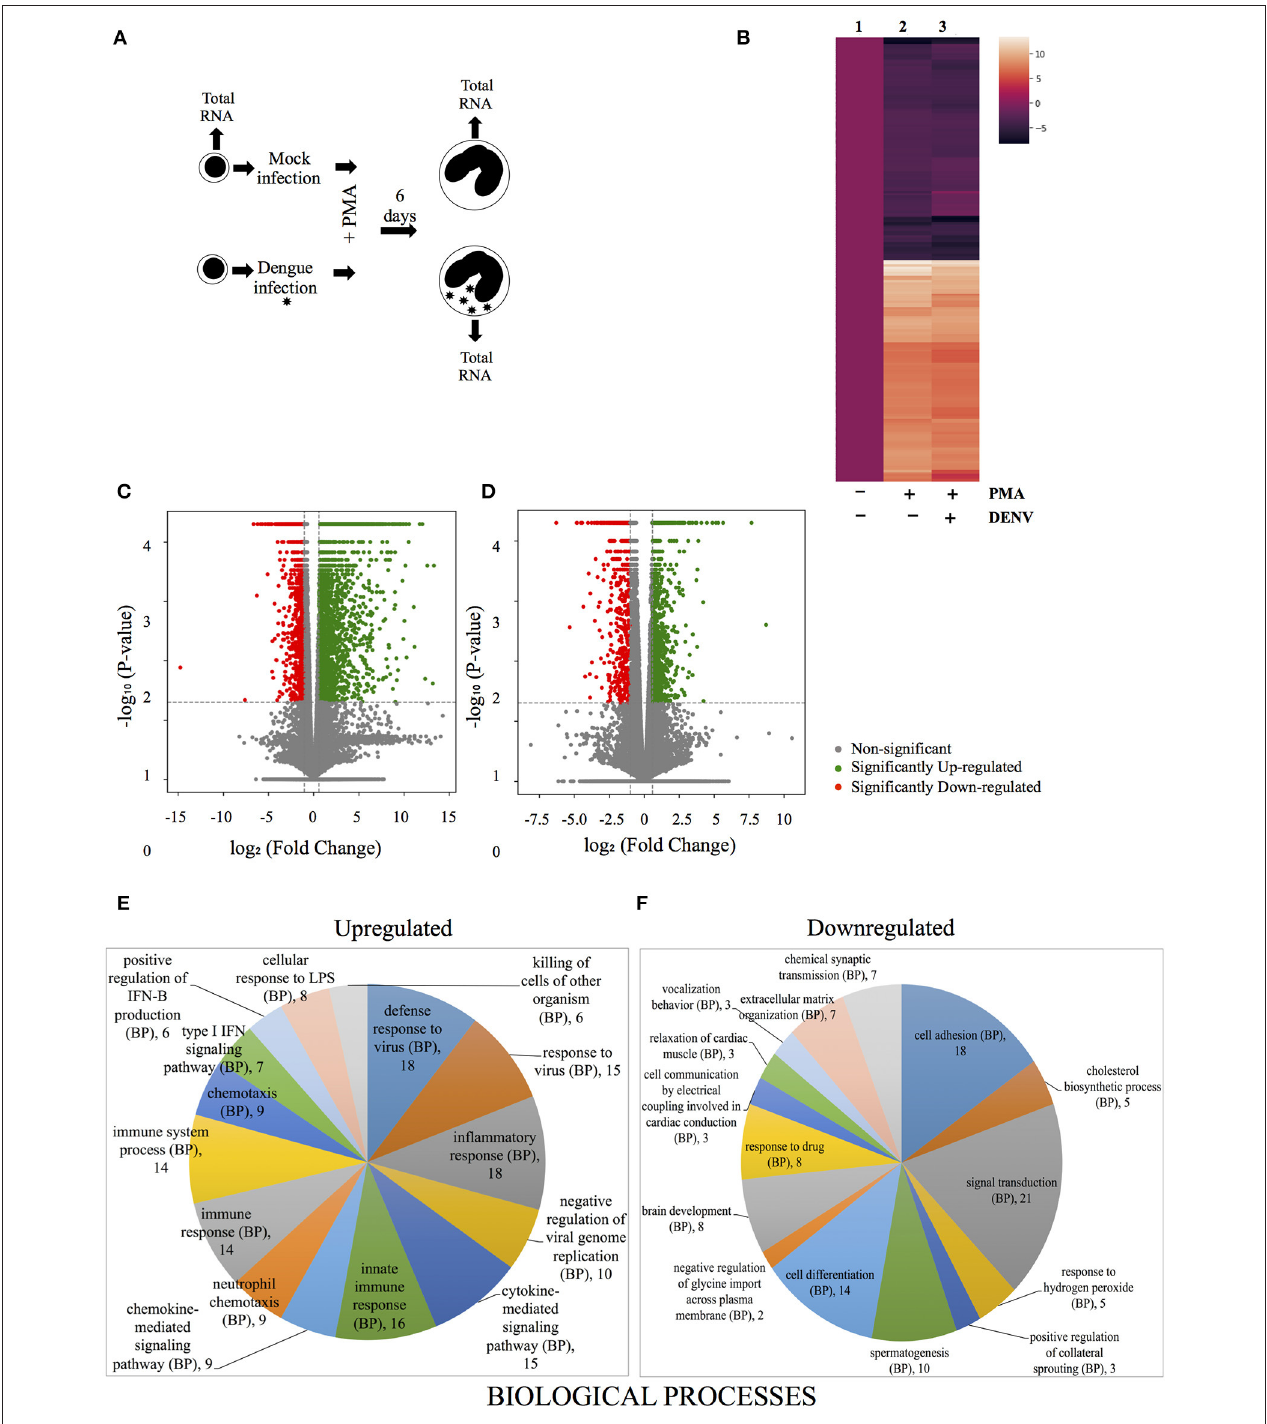
FIGURE 3 | Comparison of transcriptome between uninfected and DENV-infected differentiating cells. (A) Schematic representation of the steps for analysis of differential gene regulation in uninfected or DENV-infected K562 cells, undergoing PMA-induced differentiation compared to uninfected cells at 0h. (B) Heatmap depiction of the extent of differential regulation in the top 200 genes deregulated by PMA in uninfected cells (compare column 2 and 1) or in DENV-infected cells (compare columns 3 and 1). The transcript level at 0h is represented by column 1 while that after 6 days of PMA treatment of uninfected or DENV-infected cells is represented by column 2 or 3, respectively. The fold change in the transcript level were transformed to the logarithmic value to the base of 2 and plotted. (C,D) Volcano plots of differentially regulated genes. (C) All genes differentially regulated in uninfected cells after 6 days of PMA-treatment compared to those at 0h. (D) All genes that show differential regulation between uninfected and DENV-infected cells after 6 days of PMA-treatment. For both panels the differentially regulated genes